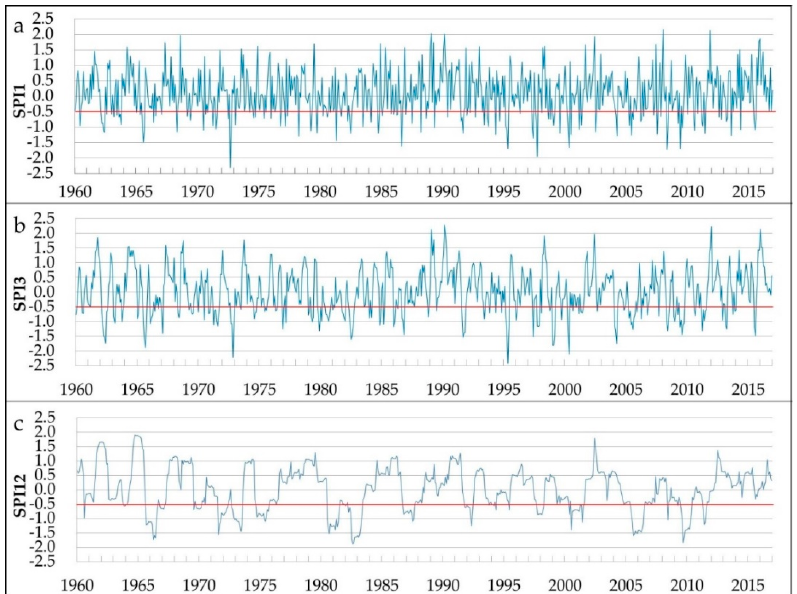
Figure 2. The standardized precipitation index (SPI) values at different timescales in Ningxia from 1960 to 2016. ( a ) SPI1 in Ningxia from 1960 to 2016; ( b ) SPI3 in Ningxia from 1960 to 2016; and ( c ) SPI12 in Ningxia from 1960 to 2016. Water 2018 , 10 , x FOR PEER REVIEW